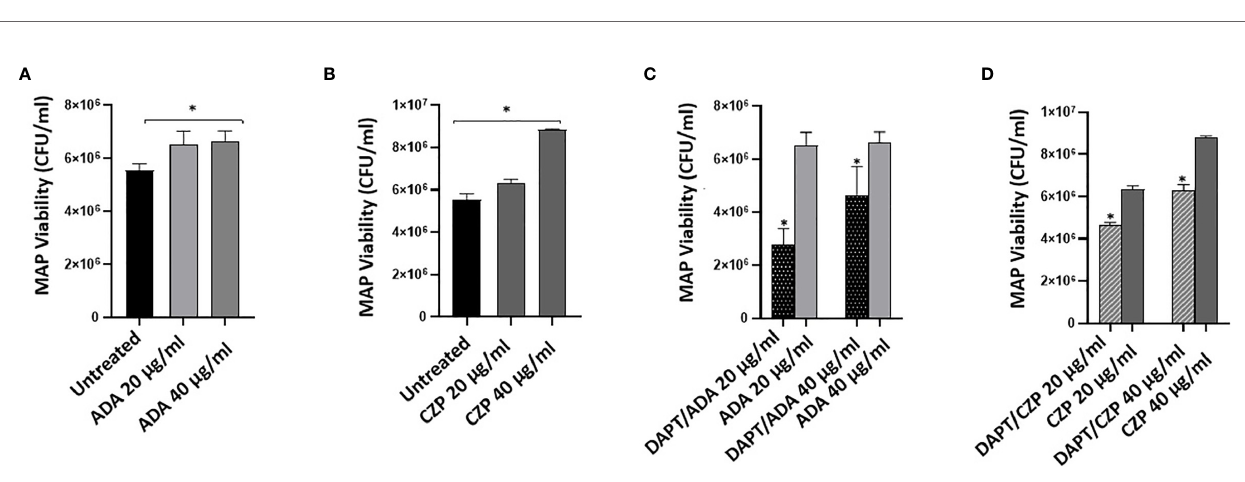
FIGURE 3 | DAPT prevents anti-TNF- a induces MAP survival in macrophages. (A, B) MAP viability in non-PEGylated (ADA) (0-40 m g/ml) and PEGylated (CZP) (0-40 m g/ml) anti-TNF- a treated macrophages. (C, D) MAP viability in pre-infection DAPT (30 m M)/post-infection PEGylated (0-40 m g/ml) and PEGylated (0-40 m g/ml) anti- TNF- a treatment. MAP viability was measured using Live/Dead Baclight bacterial viability assay. MAP viability is represented as (CFU/ml). All experiments were performed in triplets. Data are shown as mean ± SD, and signi fi cance is considered as *P <